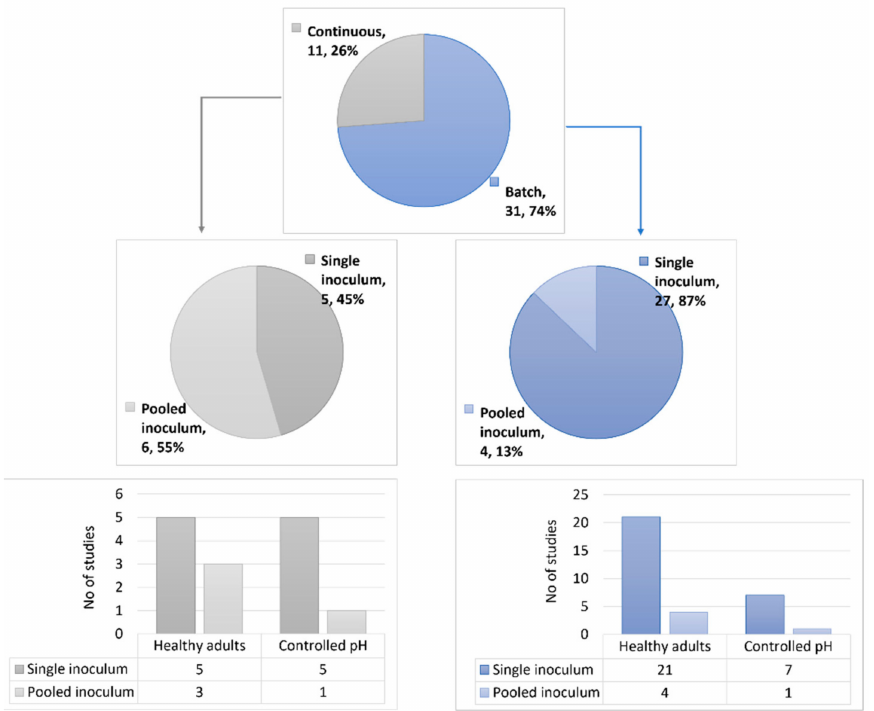
Figure 3. Overview of in vitro studies included in this systematic review according to their experi- mental